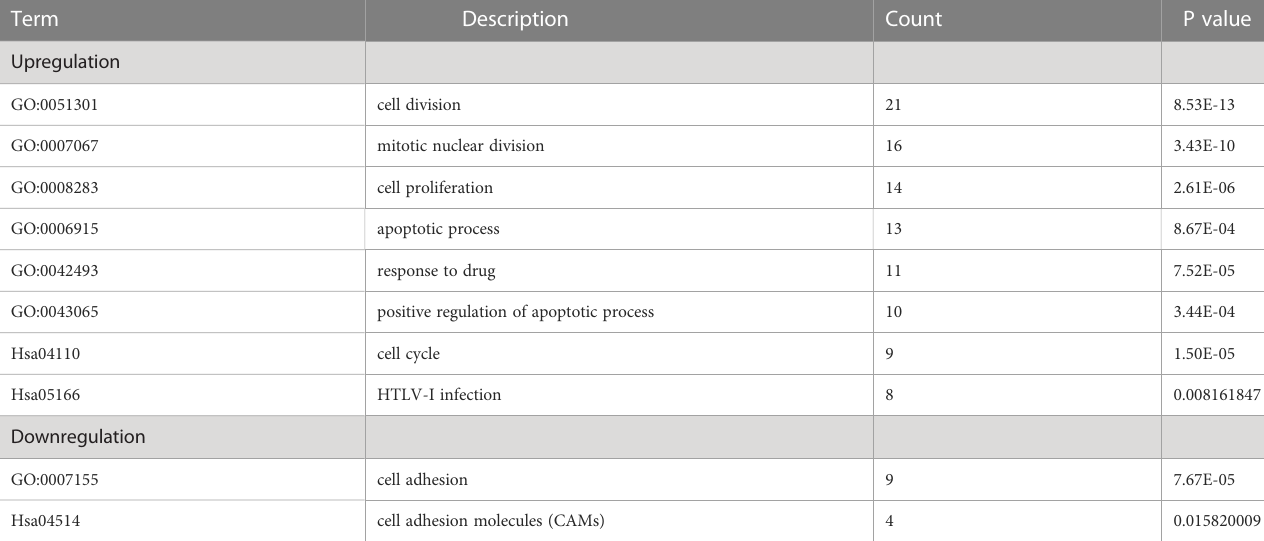
TABLE 3 Enrichment investigation of positive-regulation and negative-gulation genes with DEGs in ES specimens employing GO and KEGG Pathway.